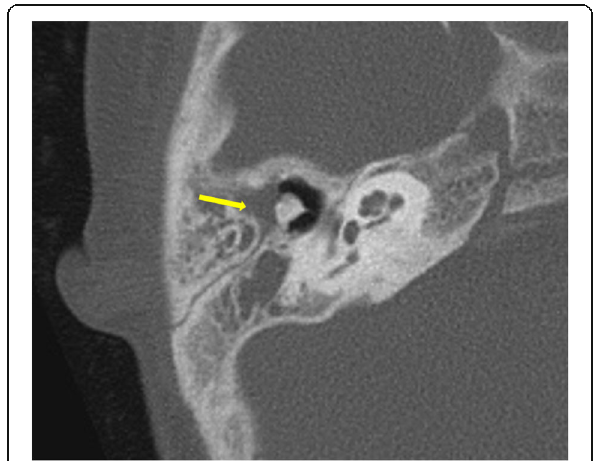
Fig. 1 Axial CT image showing non-dependent soft tissue in the Prussack ’ s space, lateral to ossicles in a patient with pars flaccida cholesteatoma (arrow)